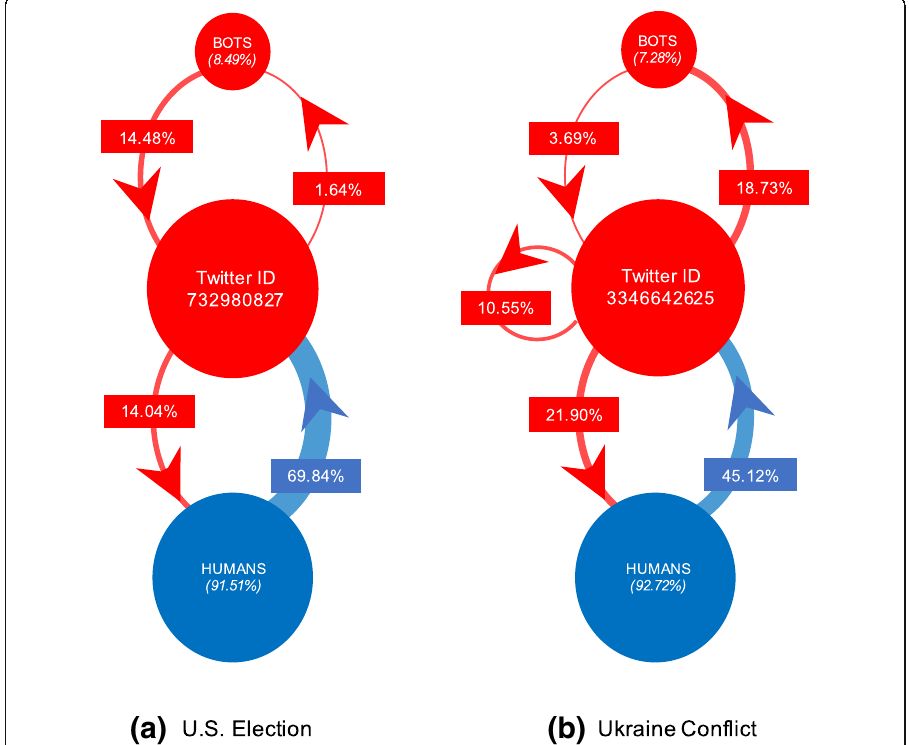
Fig. 8 Ego network retweet patterns for the top-ranking eigenvector centrality bot accounts from the ( a ) U.S. Election and ( b ) Ukraine Conflict OSN